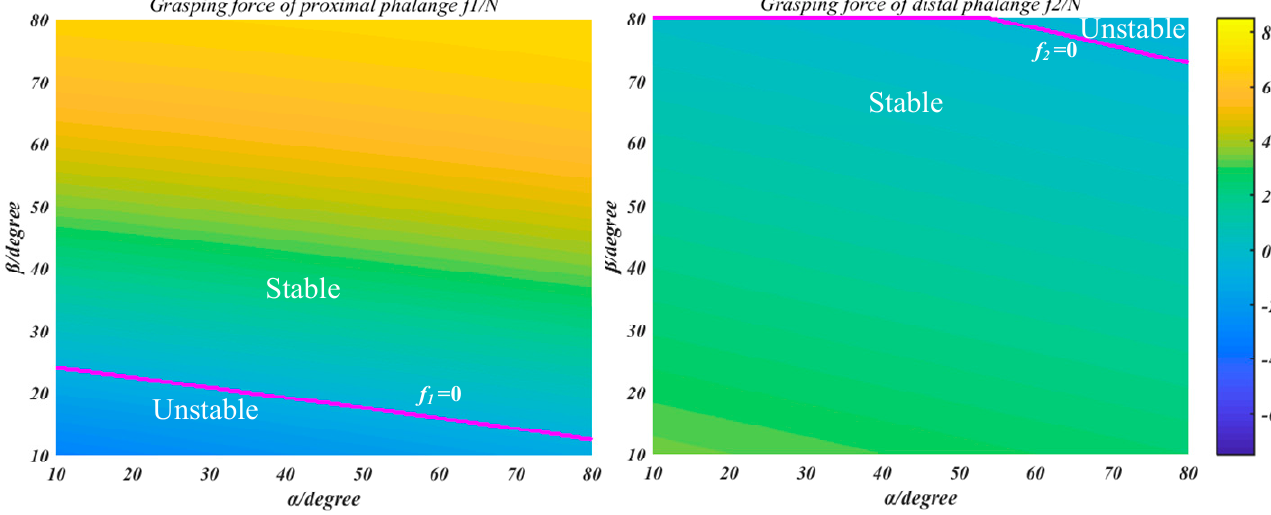
Figure 14. Stability analysis for the PASA mode.